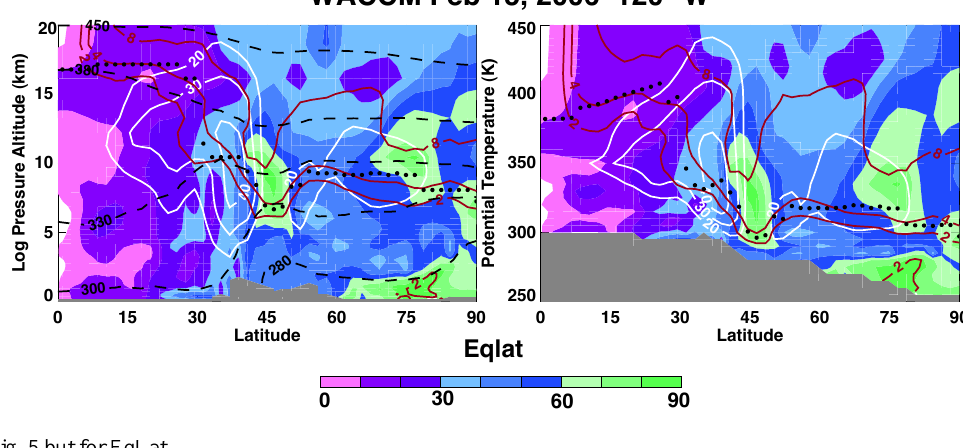
Fig. 6. As in Fig. 5 but for